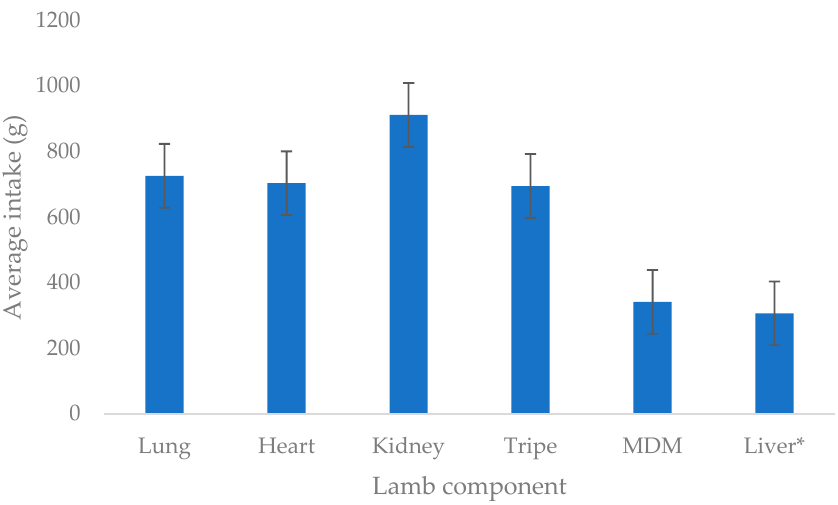
Figure 1. Average intake of the six lamb components out of the possible 1000 g served throughout the week (* maximum possible intake of liver was 325 g compared to 1000 g for the other components).